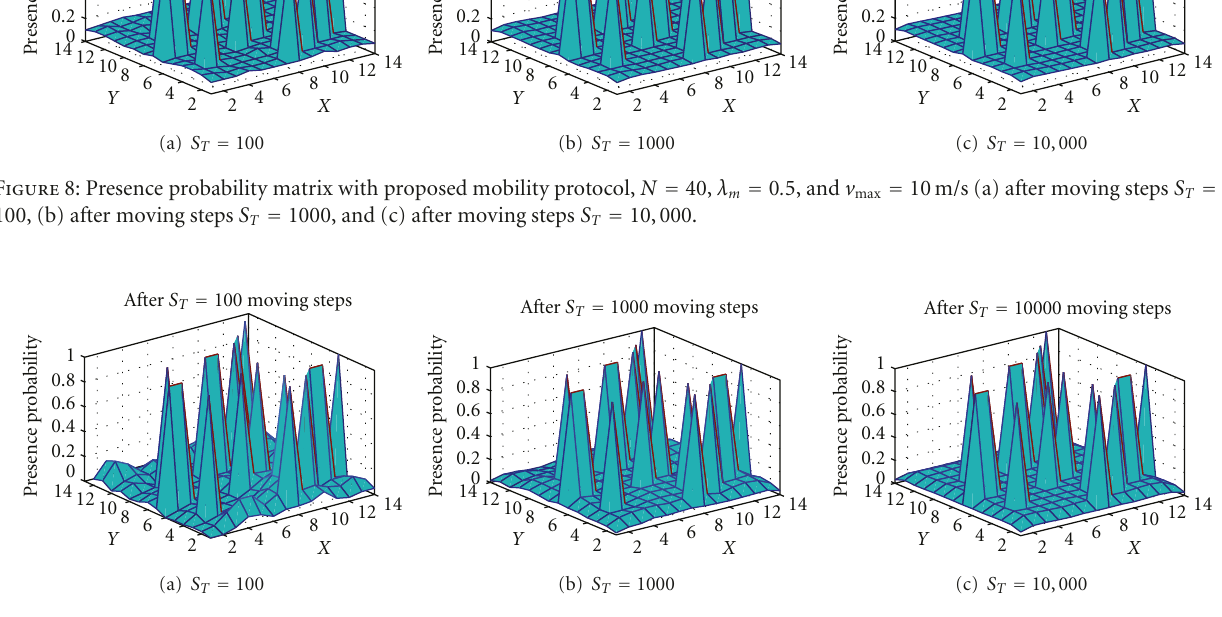
Figure 9: Presence probability matrix with proposed mobility protocol, N = 40, λ m = 0 . 5, and v max = 10m/s (a) after moving steps S T = 100, (b) after moving steps S T = 1000, and (c) after moving steps S T =